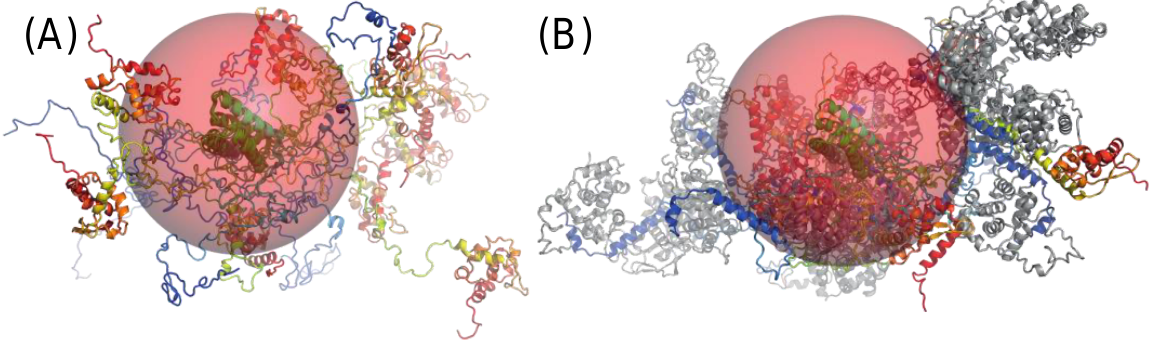
Figure 8. Comparison of ensemble models of P FL and of the 2P − 2N N ∆ 230 − P FL complex. ( A ) Full-length P dimers. Representative ensemble of the five conformers of dimeric P FL selected by GAJOE to reproduce SAXS data [17]. Each P protomer is colored from N-terminus (blue) to C-terminus (red) and the conformers were aligned by superimposing their individual dimerization domain. The semi-transparent red sphere has a radius of 4.9 nm corresponding to the radius of gyration determined from SAXS data. ( B ) 2P − 2N N ∆ 230 − P FL complex. Representative ensemble of the four conformers of the 2P − 2N N ∆ 230 − P FL complex selected by GAJOE to reproduce SAXS data (Figure 7E). Each P protomer is colored from N-terminus (blue) to C-terminus (red), the N ∆ 23 molecules are shown in gray and the conformers were aligned by superimposing their individual dimerization domain. The semi-transparent red sphere has a radius of 5.1 nm corresponding to the radius of gyration deter- mined from SAXS data.